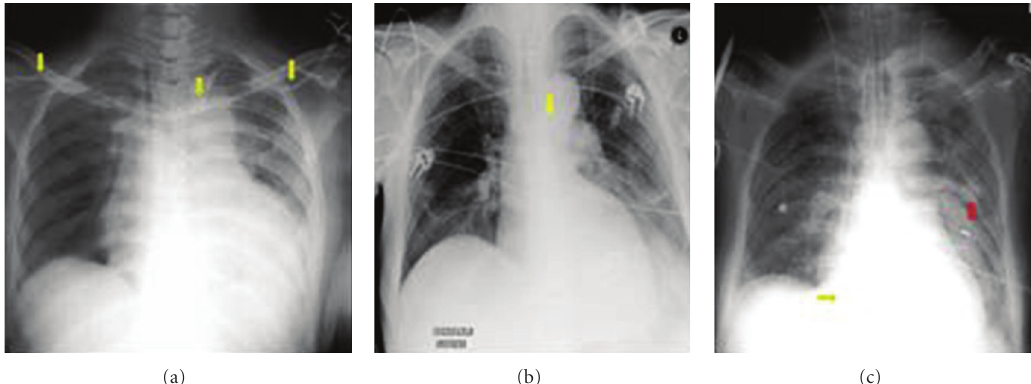
Figure 1: Portable AP radiographs on three di ff erent patients showing malpositioned central venous lines. (a) It shows that the IV line has crossed from the left axillary to the right axillary vein (arrows). (b) It shows the central line placed via the right jugular vein has entered the left brachiocephalic vein (arrow). (c) It shows that the tip of the central line has entered the inferior vena cava (yellow arrow), whilst the NGT has entered the left lower lobe bronchus associated with a left basal pneumonia.